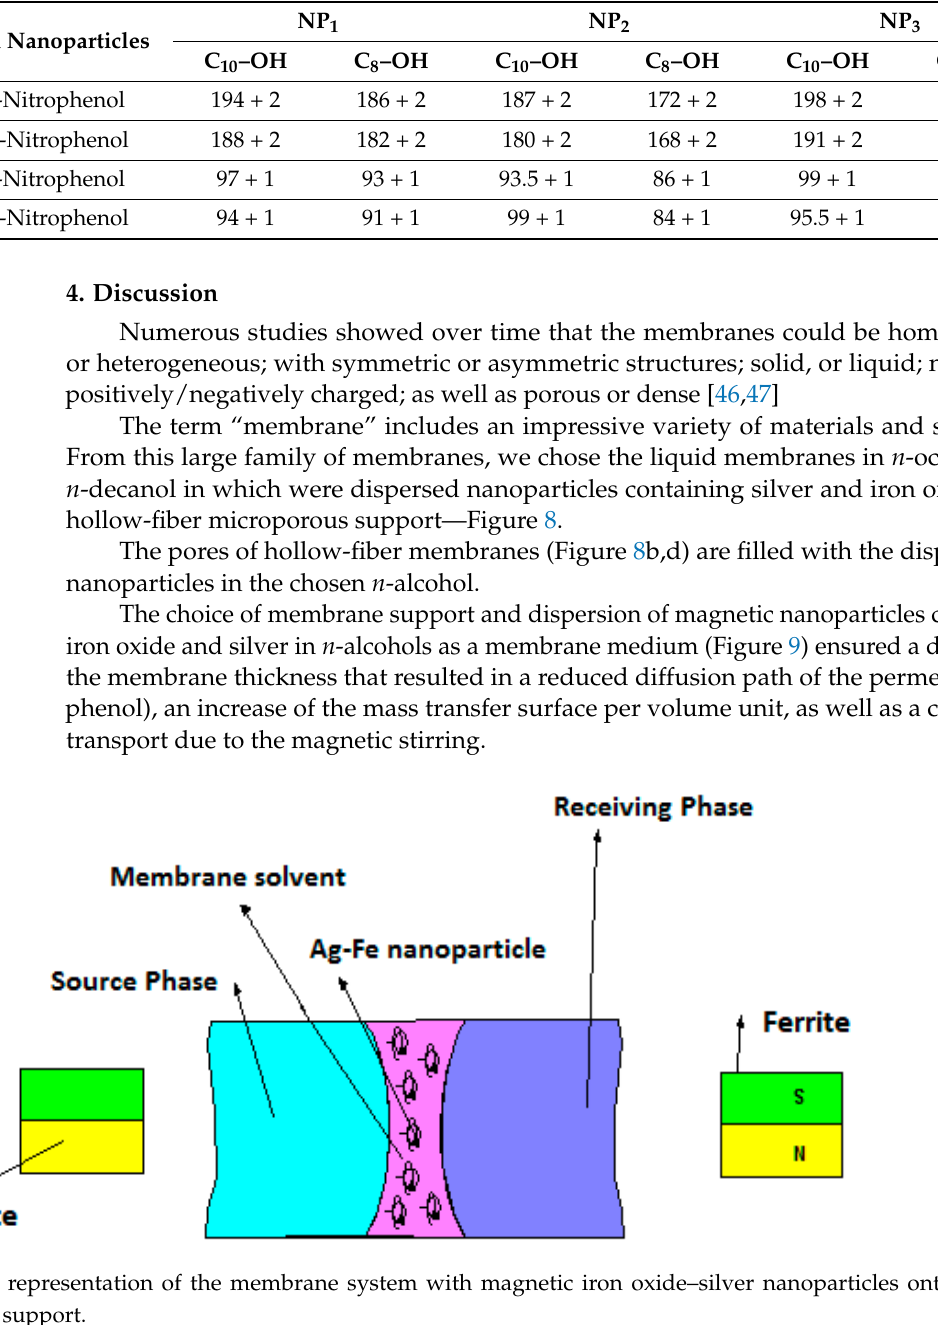
Table 2. The operating time was 30 min at 40 oscillations/min. Table 2. The flux (J) and the extraction efficiency (EE) for o- and m -nitrophenols pertraction. Liquid Membrane with Nanoparticles